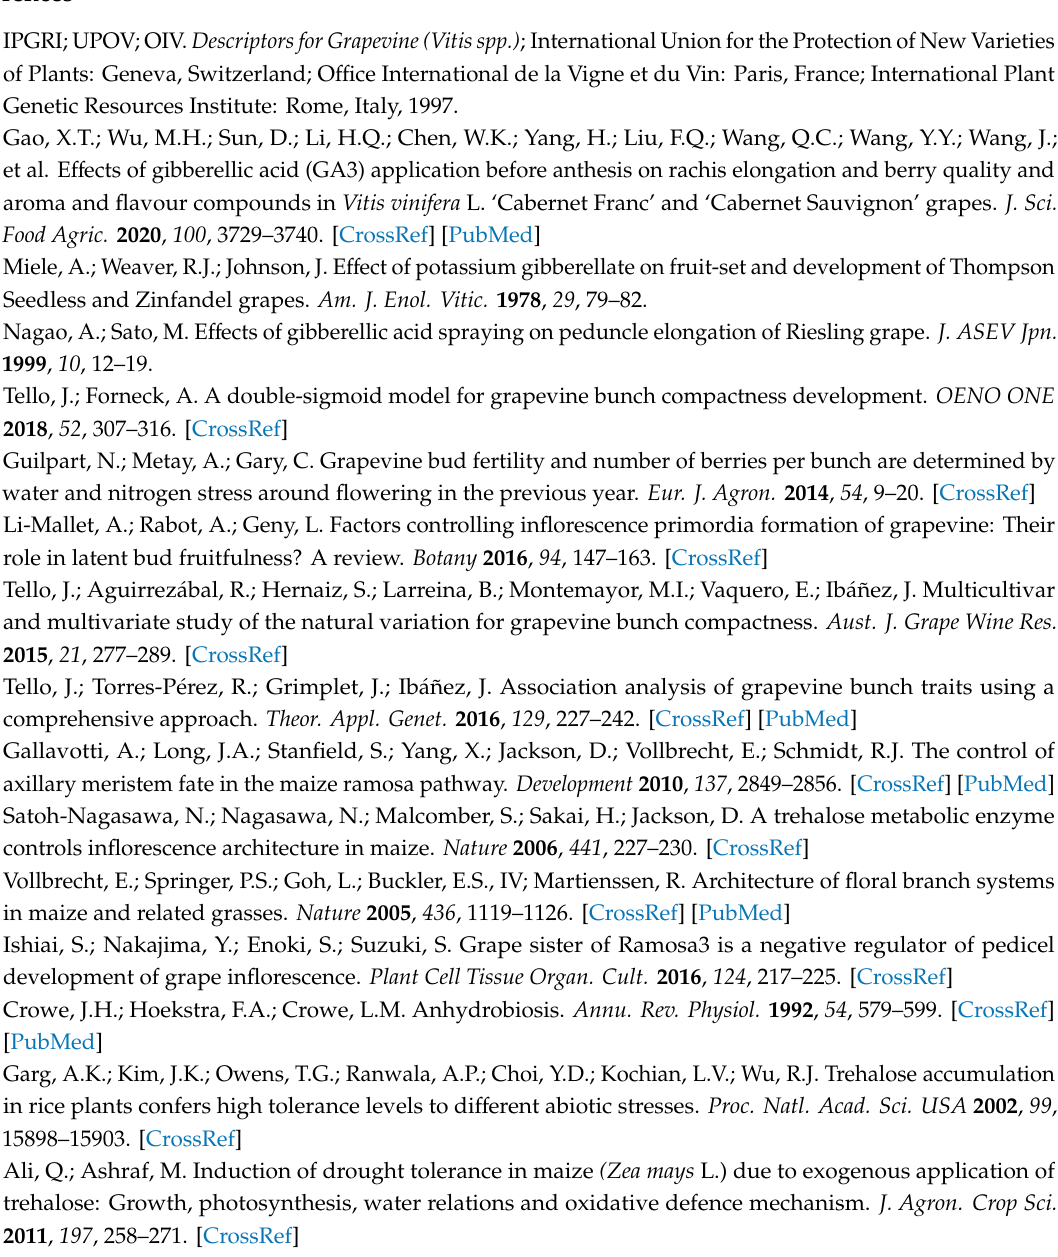
Figure S1: Injection of trehalose into buds of field-grown grapevines using a